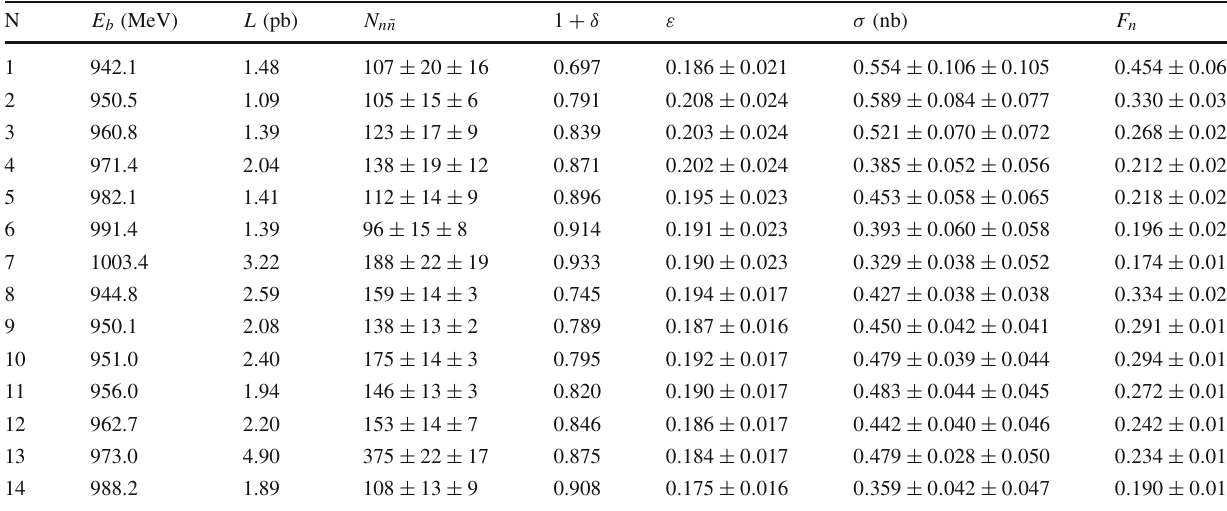
quoted errors for N , σ are statistical and systematic. For the detection efficiency, the systematic uncertainty is quoted. For F n , the combined statisticaland systematicuncertainty is listed. Rows 1–7 (8–14) list data for 2017